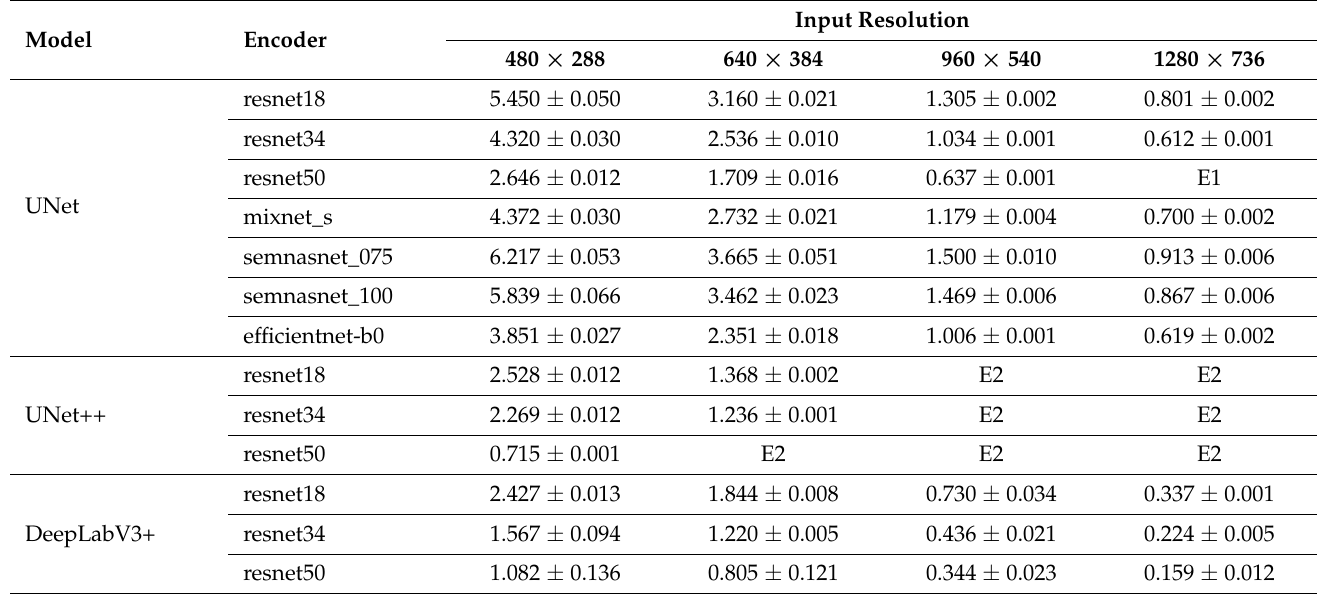
Table 3. One-batch inference speed (images per second) measurements of crowd counting models for Raspberry Pi 4 with Intel Neural Compute Stick